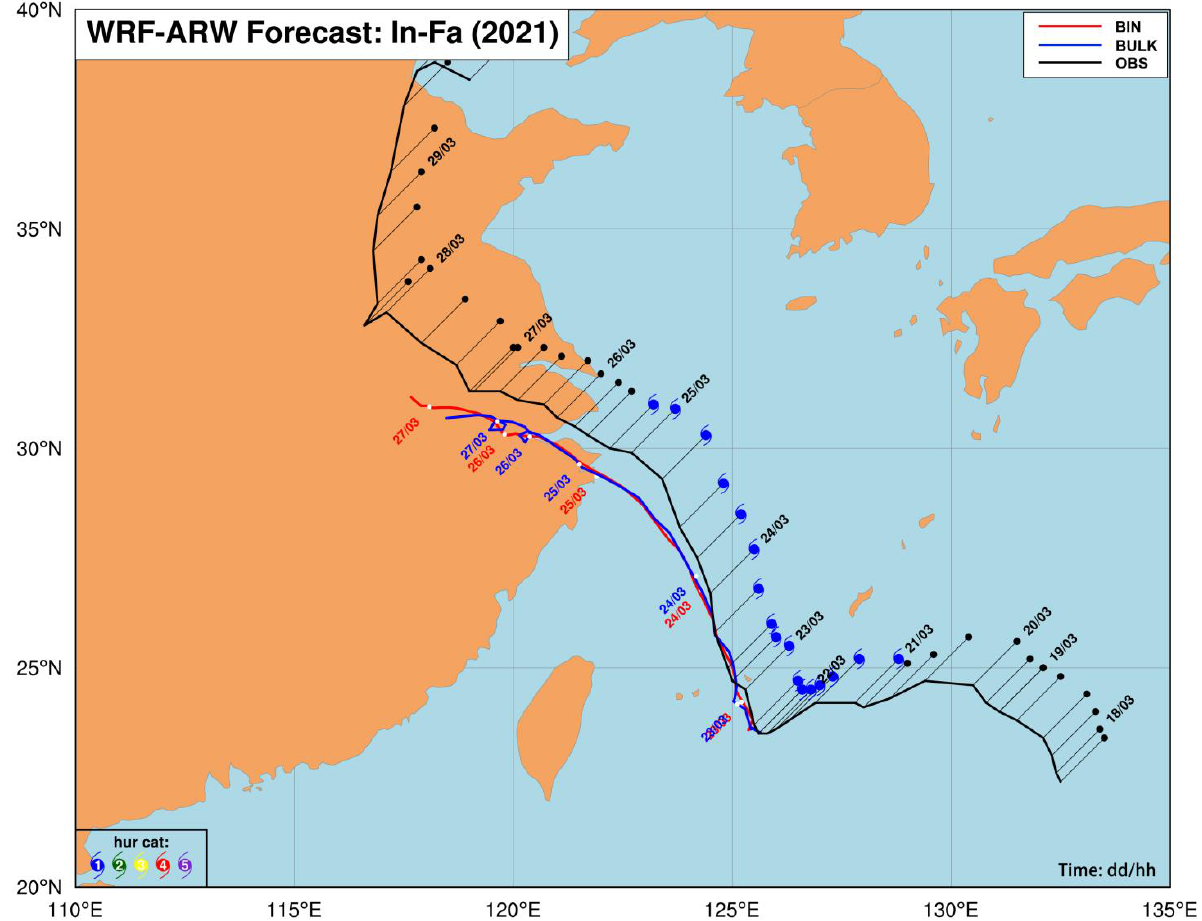
Figure 1. WRF-ARW simulated Typhoon In-Fa tracks during the time from 1200 UTC 22 July to 1200 UTC 27 July 2021, as compared with the CMA best track data [45]. The simulated tracks are marked with white dots at 0300 UTC each day from 23 to 27 July 2021. The corresponding times are also labeled on the observed track for comparison. Following the Saffir – Simpson Hurricane Scale, the observed typhoon intensity is depicted with different hurricane categories (from cat-1 to cat-5). The blue/green/yellow/red/purple cyclone symbols represent category-1/-2/-3/-4/-5 hurricane, respectively. The black solid dots represent tropical storm or tropical depression. Note the format of time on the map is dd/hh.